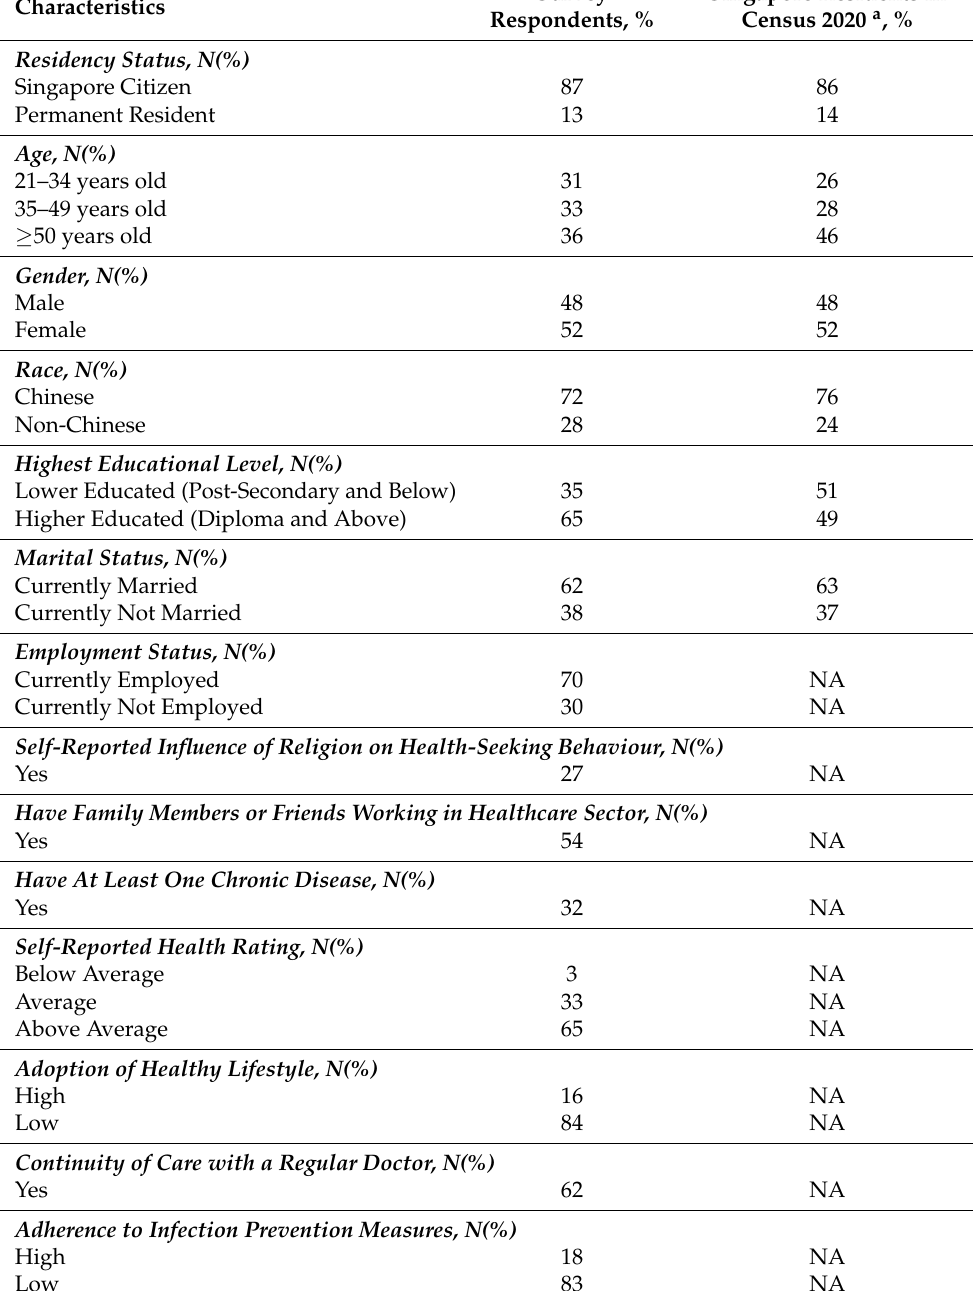
Table 1. Characteristics of 2004 Singapore residents surveyed between November 2020 and January